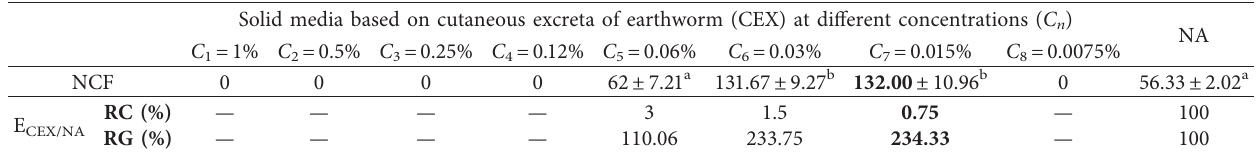
Table 3: Growth of Escherichia coli in solid media based on cutaneous excreta of earthworm Aporrectodea molleri (CEX) at different concentrations ( C n : g/100 ml).